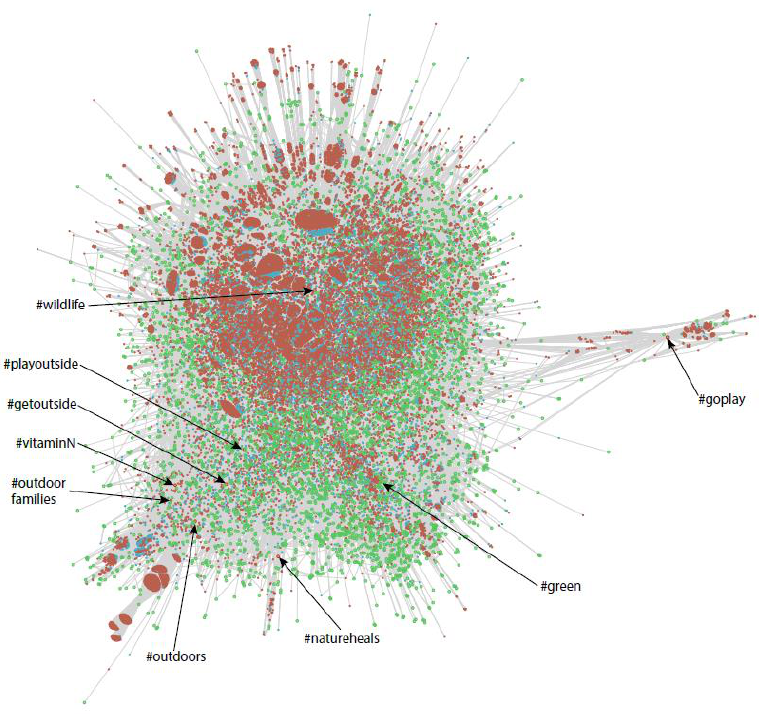
Figure 5. Tweets, retweets and hashtags distribution (100,000 sample).